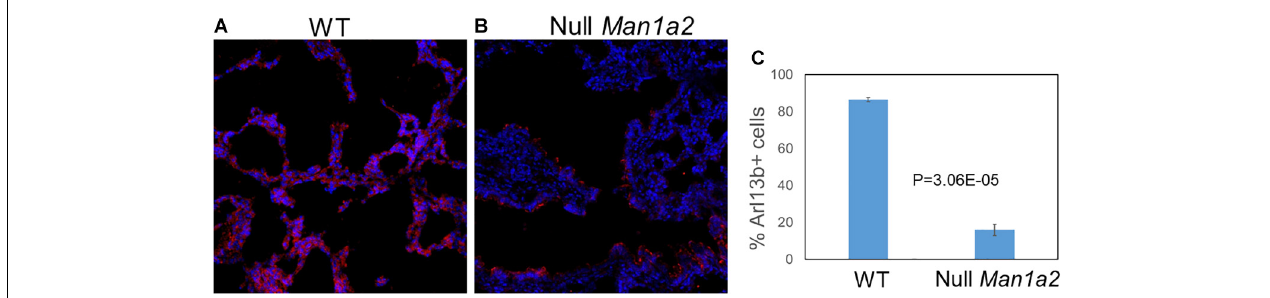
FIGURE 6 | Man1a2 knockdown in mouse leads to decreased cilia development in lung. Confocal microscopy showed the cilia marker Arl13b (red) and nuclei (blue, Dapi) in the lung from the (A) WT ( Man1a2 + / + ) and (B) Null Man1a2 ( − / − ) pups. Scale bars: 50 µ m. (C) The bar diagram showed the percent Arl13b+ cells (% Dapi) in lung from four WT and four Null Man1a2 pups. Error bars: ±